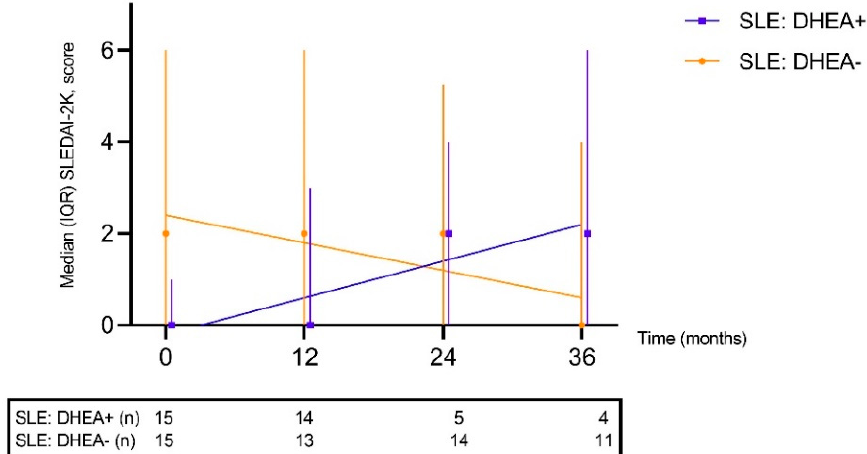
Figure 1. Global disease activity assessed by the systemic lupus erythematosus disease activity index-2000 (SLEDAI-2K) over time depicted for patients exposed to DHEA and for sex- and age-matched controls. No significant changes over time were observed.